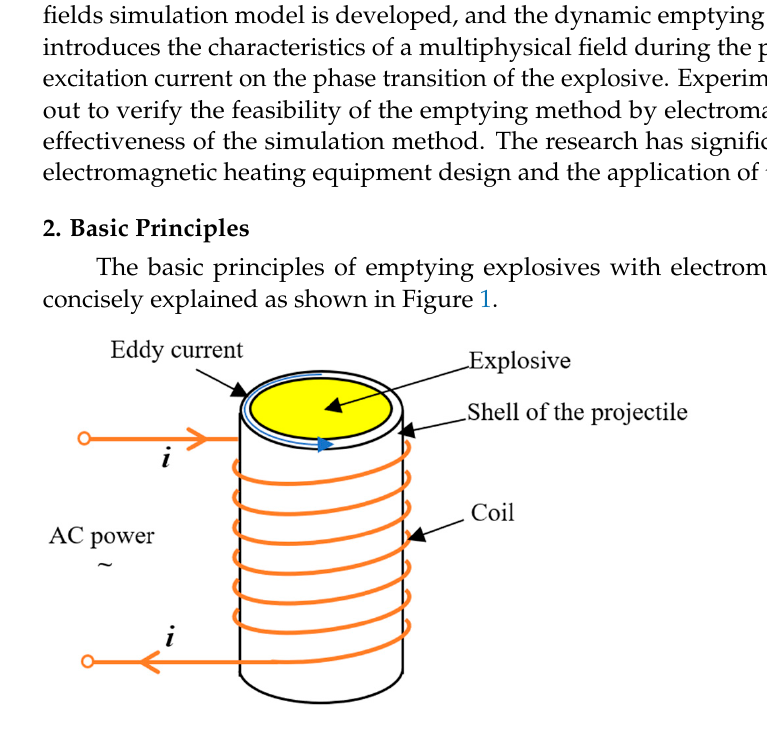
Figure 1. Schematic diagram of emptying explosives with electromagnetic heating.